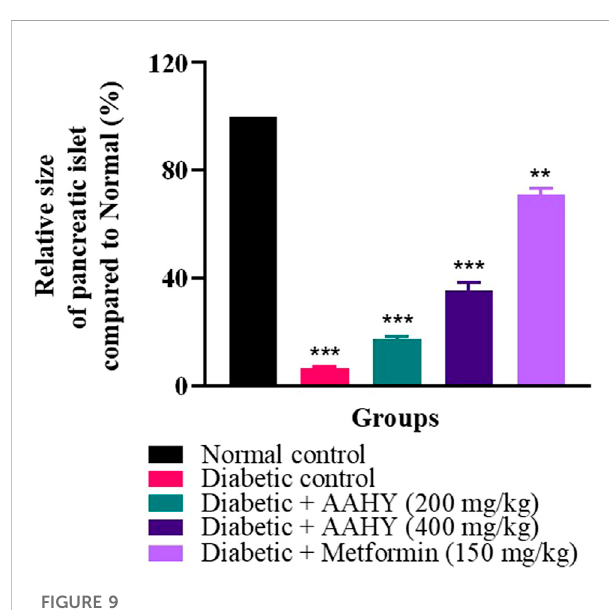
FIGURE 9 Graphshowingtherelativesizeofthepancreaticisletscompared to that of the normal control. The error bar denotes mean ± SEM, and n = 6 for each group. ** p < 0.01 and *** p < 0.001 versus the normal control group. SEM: standard error of